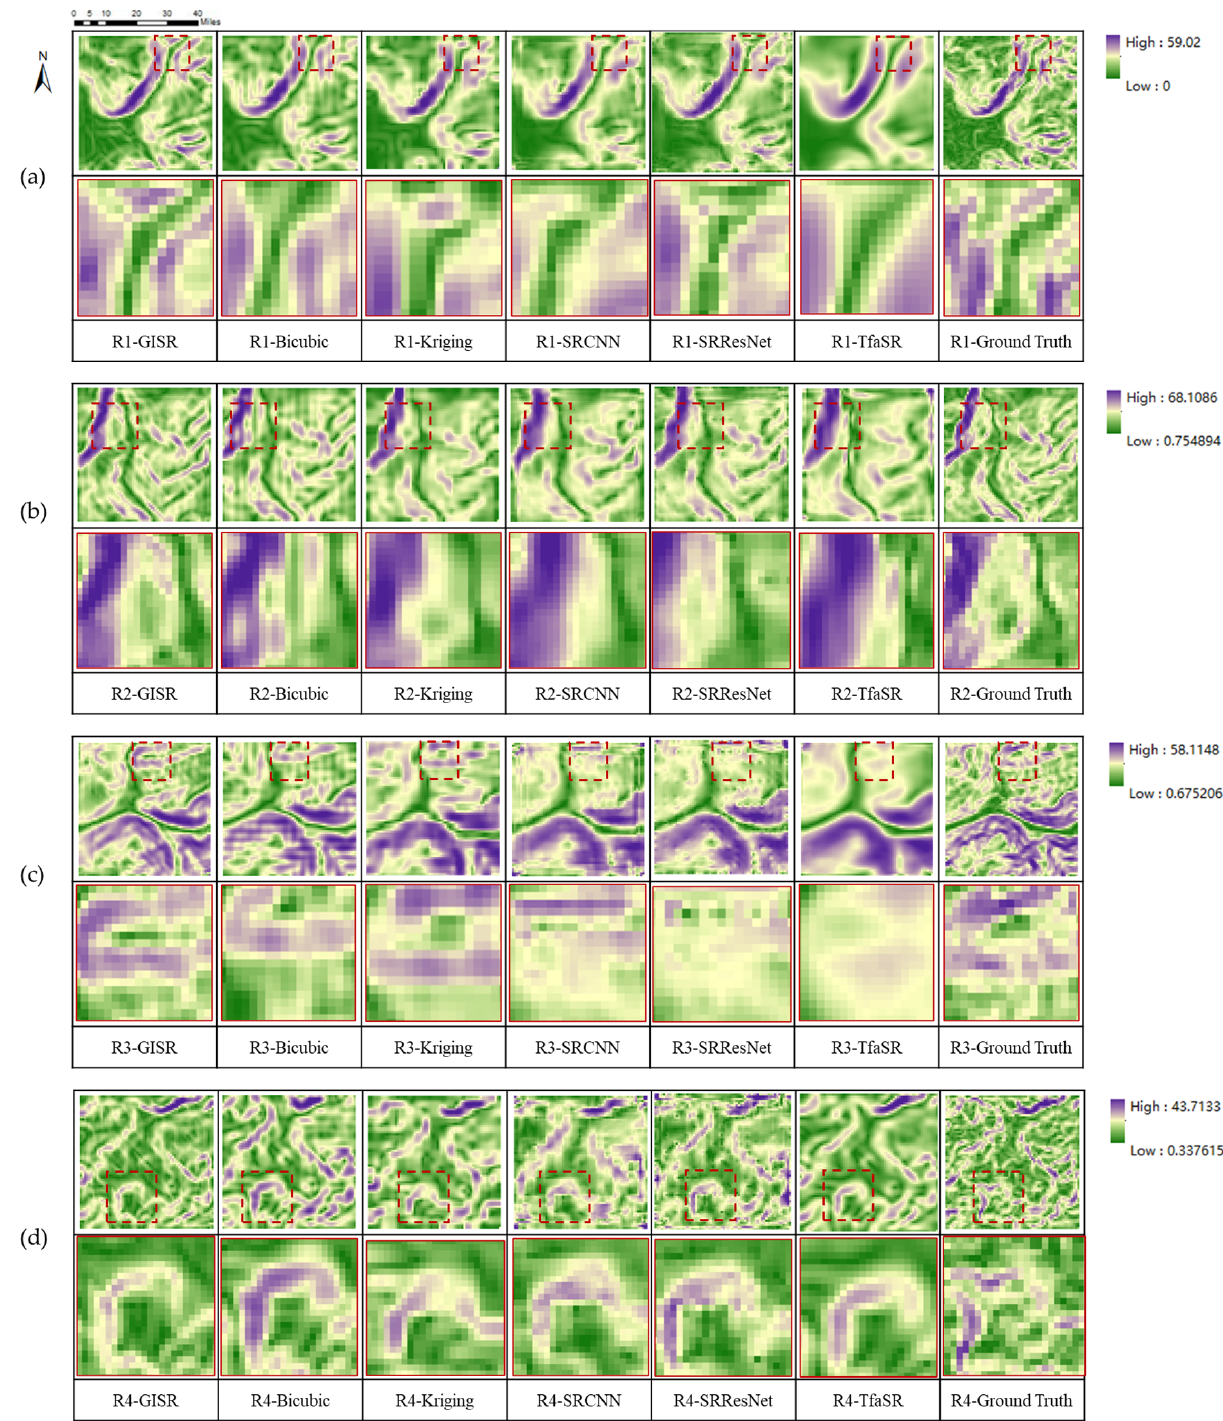
Figure 12. The DEM SR slope results for four different methods: ( a – d ) are the test regions R1, R2, R3, and R4, respectively (The contents of the solid wireframe are the enlarged details of the dotted wireframe).